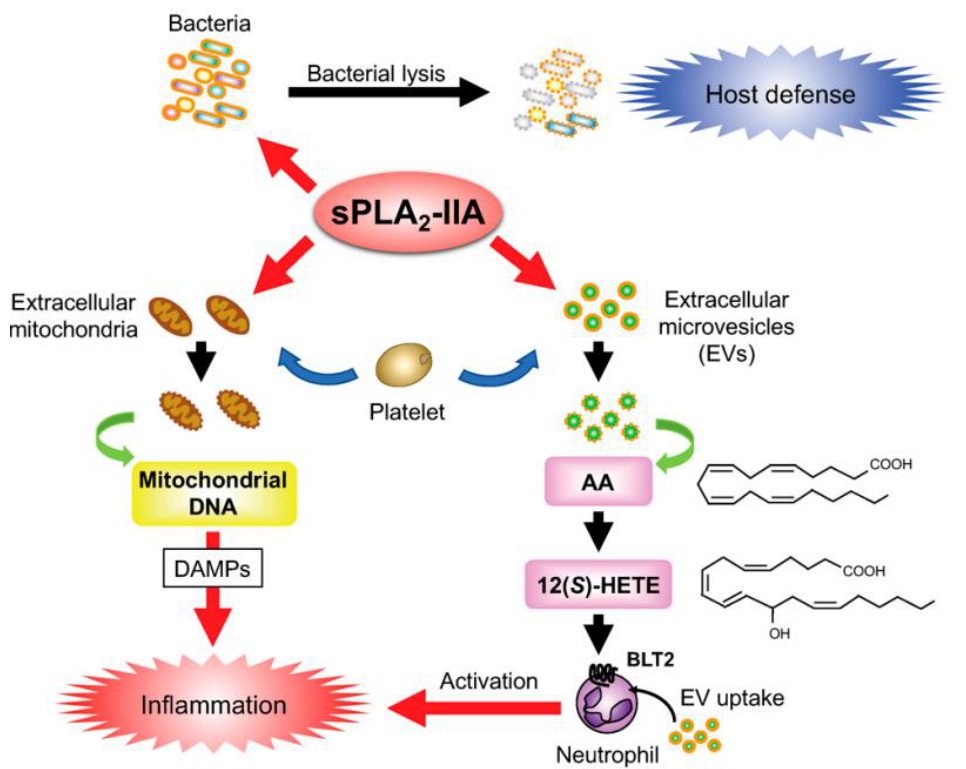
Figure 17. Physiological roles of sPLA2-IIA, as a key player in host defense against foreign self- assembled lipid structures in the blood, through the degradation of bacterial membranes, and in inflammation, where it hydrolyzes arachidonic acid from extracellular micro-vesicles, which subse- quently feeds the inflammatory pathway. It also cleaves cardiolipin from extracellular mitochondria (released from activated neutrophils, platelets, mast cells, lymphocytes, etc.), liberating mitochondrial DNA that potentiates inflammation [62].